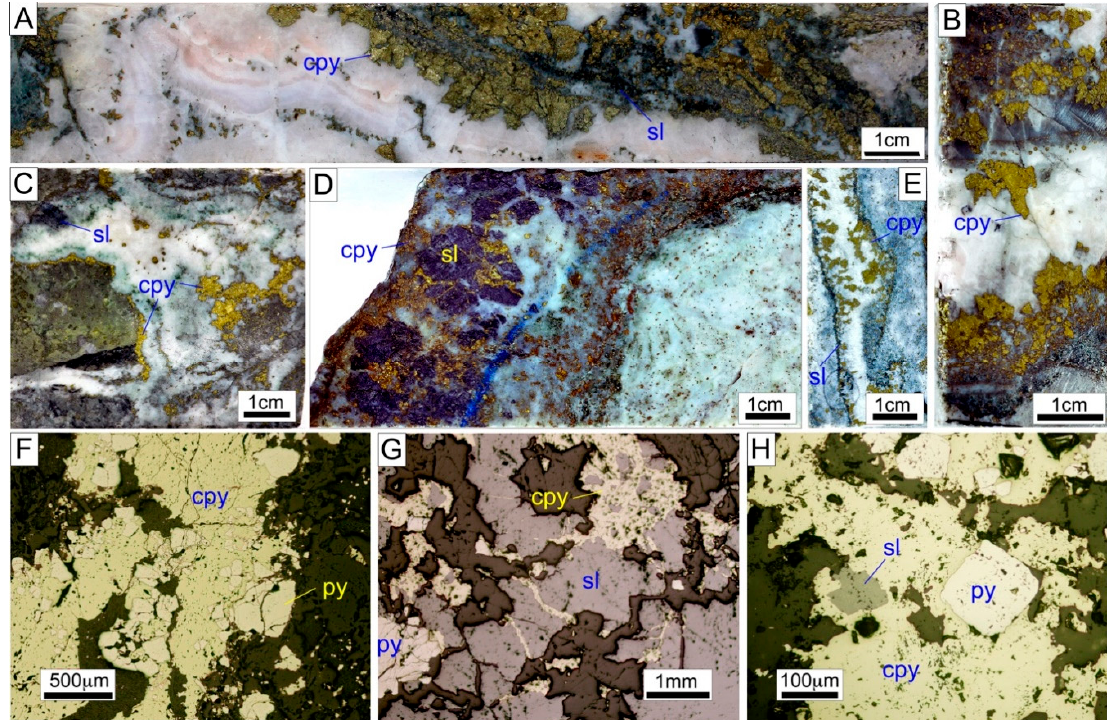
Figure 8. Hand sample photographs ( A – E ) and polished section photomicrographs (reflected light: F – H ) illustrating textures and mineralogy of the stockwork mineralization at the Romero deposit. ( A ) In this sample, a colloform texture is described by quartz bands with different colors and crusts and bands enriched in sulfides; ( B ) detail of a quartz–sulfide vein in which chalcopyrite crystals located at its margins grew inward as protrusions perpendicular to the vein walls; ( C ) concentric bands of quartz and chalcopyrite grew away from a rock fragment describing a cockade texture; ( D ) cm-sized sphalerite crystals crosscut by chalcopyrite veinlets; ( E ) the margins of this vein are lined with sphalerite, which was overgrown by chalcopyrite protrusions; the remaining central space was filled with white quartz; ( F ) chalcopyrite cements anhedral pyrite grains; ( G ) detail of chalcopyrite veinlets crosscutting sphalerite mineralization; ( H ) chalcopyrite mineralization cements subhedral to anhedral pyrite crystals, fills vuggs within these mineral and appears as very fine blebs within sphalerite (chalcopyrite disease). Abbreviations: cpy = chalcopyrite; sl = sphalerite; py = pyrite.